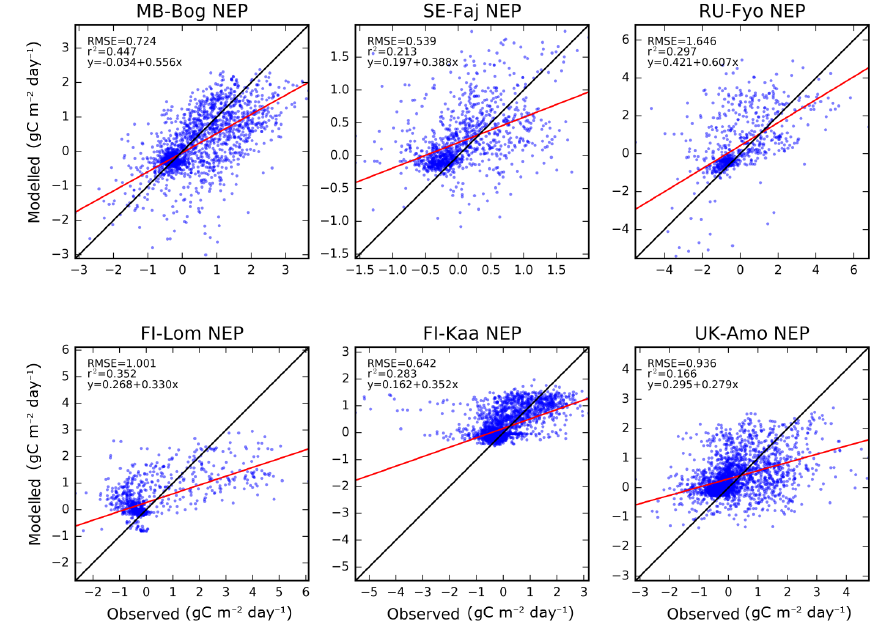
Figure 13. Scatter plots of simulated vs. observed daily NEP (gCm − 2 day − 1 ) in bogs and